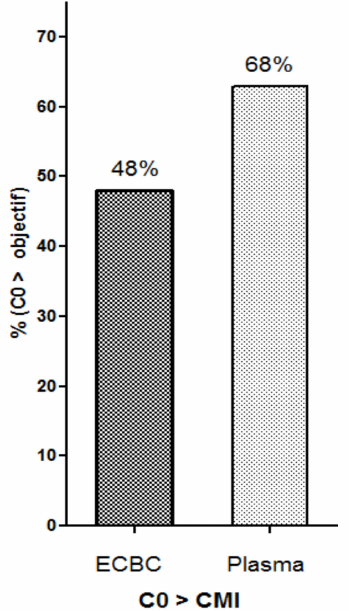
Figure 3. Concentration of voriconazole in sputum over time after dose administration for five patients.